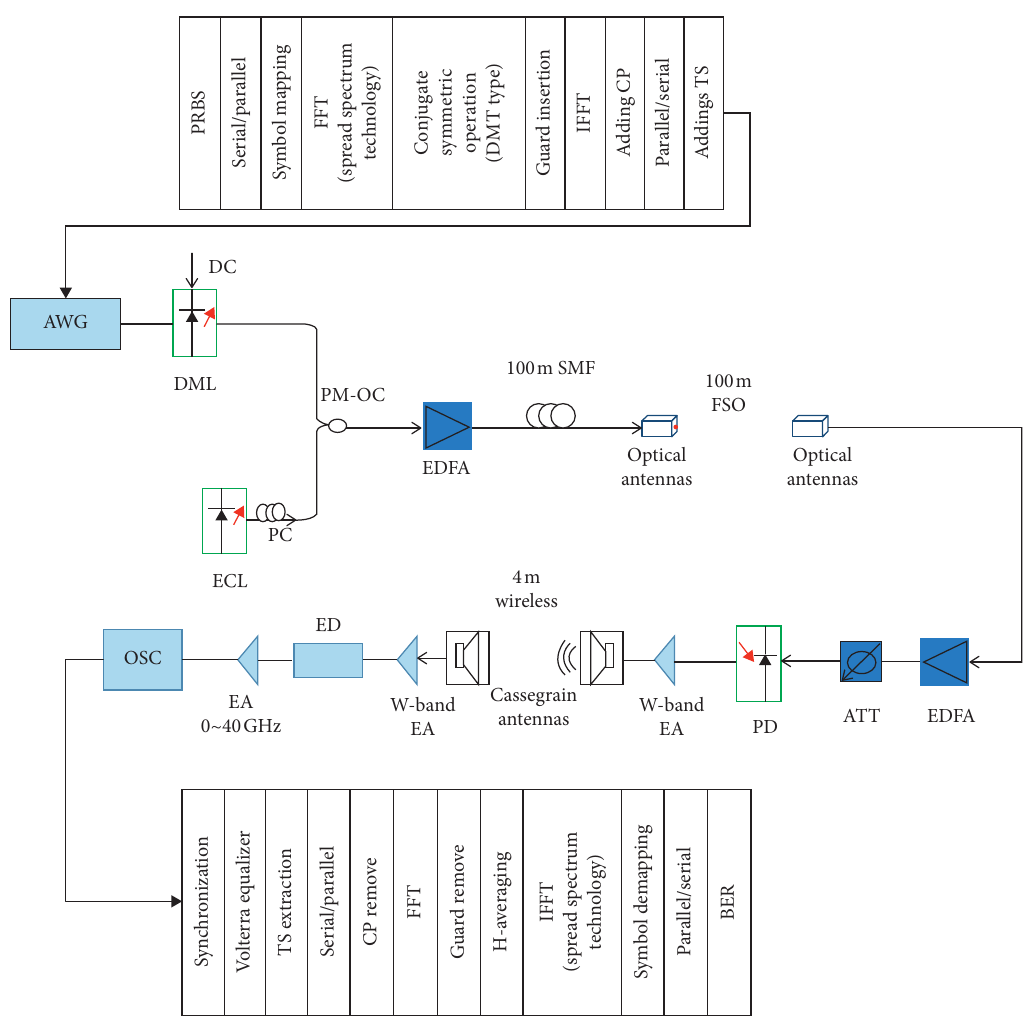
Figure 3: Experimental setup diagram of the fusion